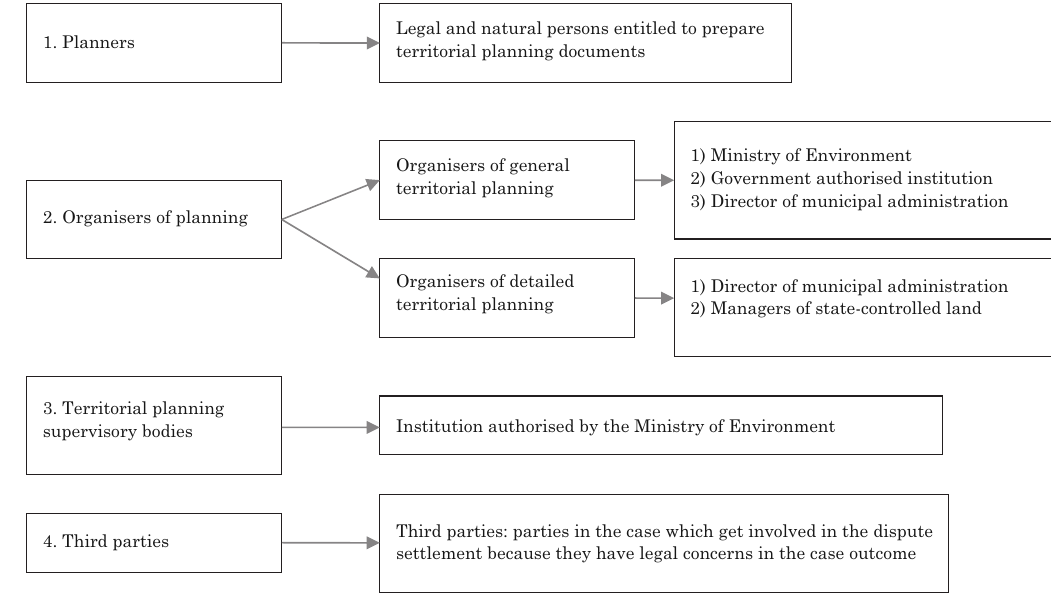
Figure 1. Classification of parties involved in territorial